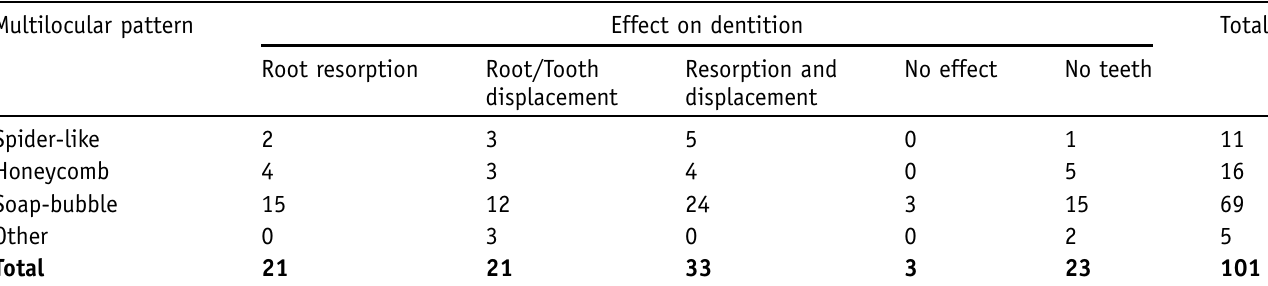
Table IV. Multilocular pattern of ameloblastoma and its effects on dentition.